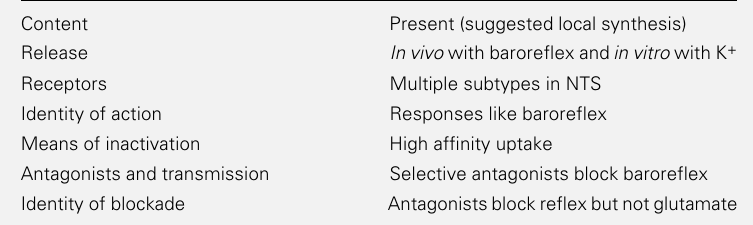
Table 1 - Glutamate in the NTS and criteria* for a neurotransmitter. *Criteria modified from Orrego